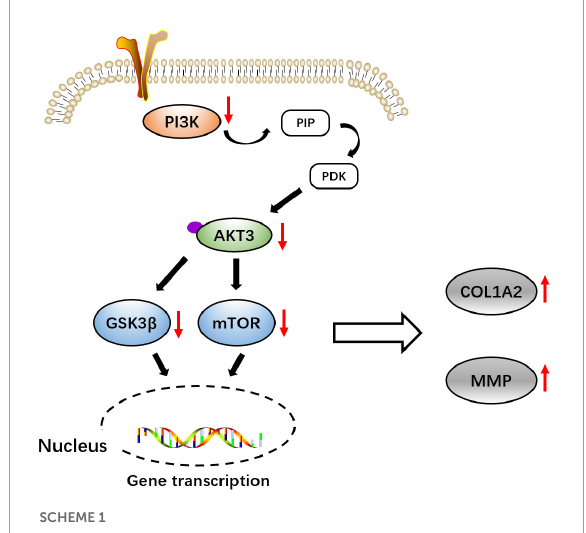
SCHEME1 Schematic diagram of the molecular pathway of COL1A2 and AKT3 might be involved in the pathogenicity of congenital talipes equinovarus